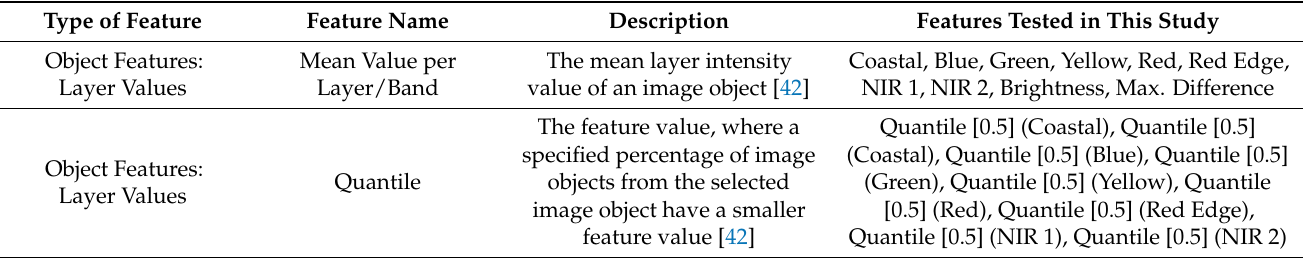
Figure 4. Segmentation and classification on the ML GS_FLAASH subset. ( a ) Non-segmented Image; ( b ) Segmented Object Mean View: Hidden Outlines; ( c ) Classified Merged Objects: Visible Object Outlines; ( d ) Classified Merged Objects: Hidden Outlines. RGB: Coastal, Blue, Green. Table 2. Set of object, class, and customized features used to classify facies in this study. Description of the features in addition to the specific features used in the current study. Quantile [0.5] refers to the 50th percentile or middle quartile of the object data per spectral